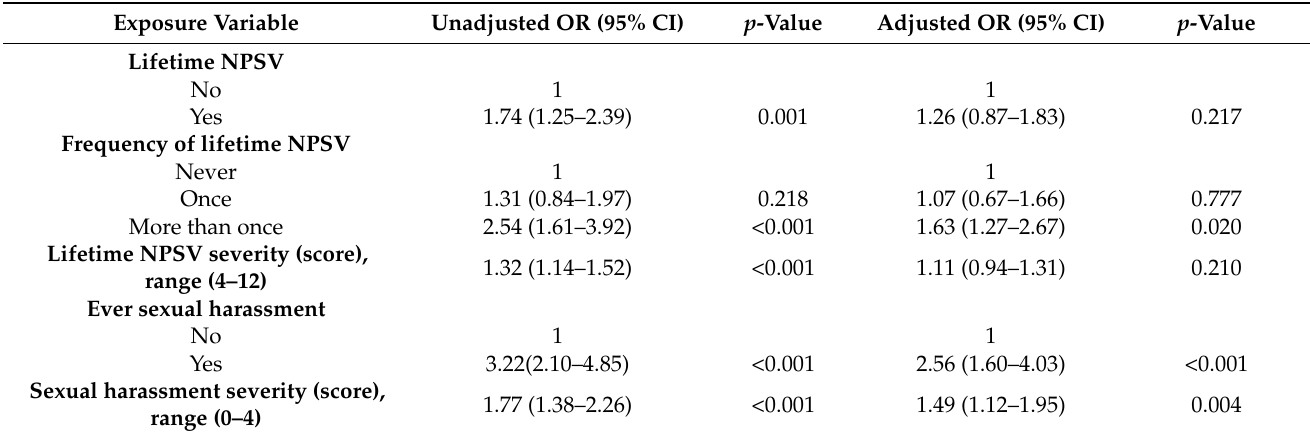
Table 4. Logistic regression analyses (odds ratios, 95% confidence intervals) for the associations of non-partner sexual violence (NPSV) and sexual harassment with